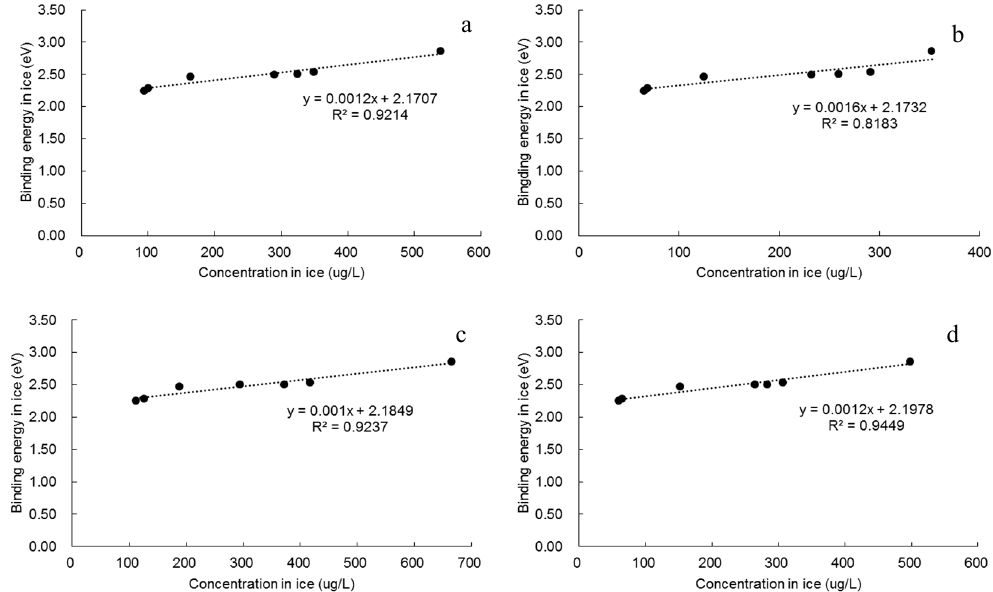
Figure 6. The relationship between concentration in ice and binding energy in ice (( a ) T = − 25 ◦ C, pH = 7, initial concentration is 10,000 µ g/L; ( b ) T = − 15 ◦ C, pH = 7, initial concentration is 10,000 µ g/L; ( c ) pH = 5, T = − 25 ◦ C, initial concentration is 10,000 µ g/L; ( d ) pH = 11, T = − 25 ◦ C, initial concentration is 10,000 µ g/L).